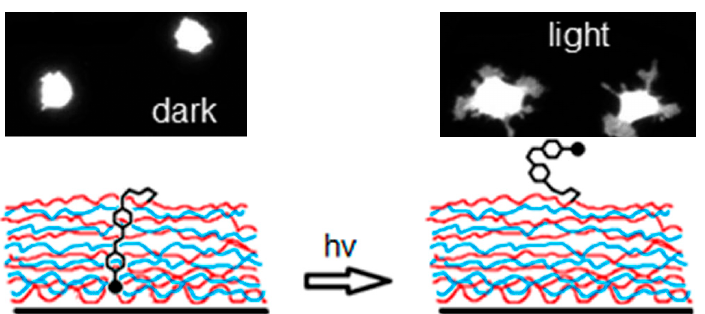
Figure 5. Typical cell surface area on the LbL films in darkness and under UV–light irradiation ( top ) and photo-induced conformational change of RGD-attached azobenzene residues in the LbL film ( bottom ). Reprinted with permission from Ref. [54]. Copyright 2012 American Chemical Society.